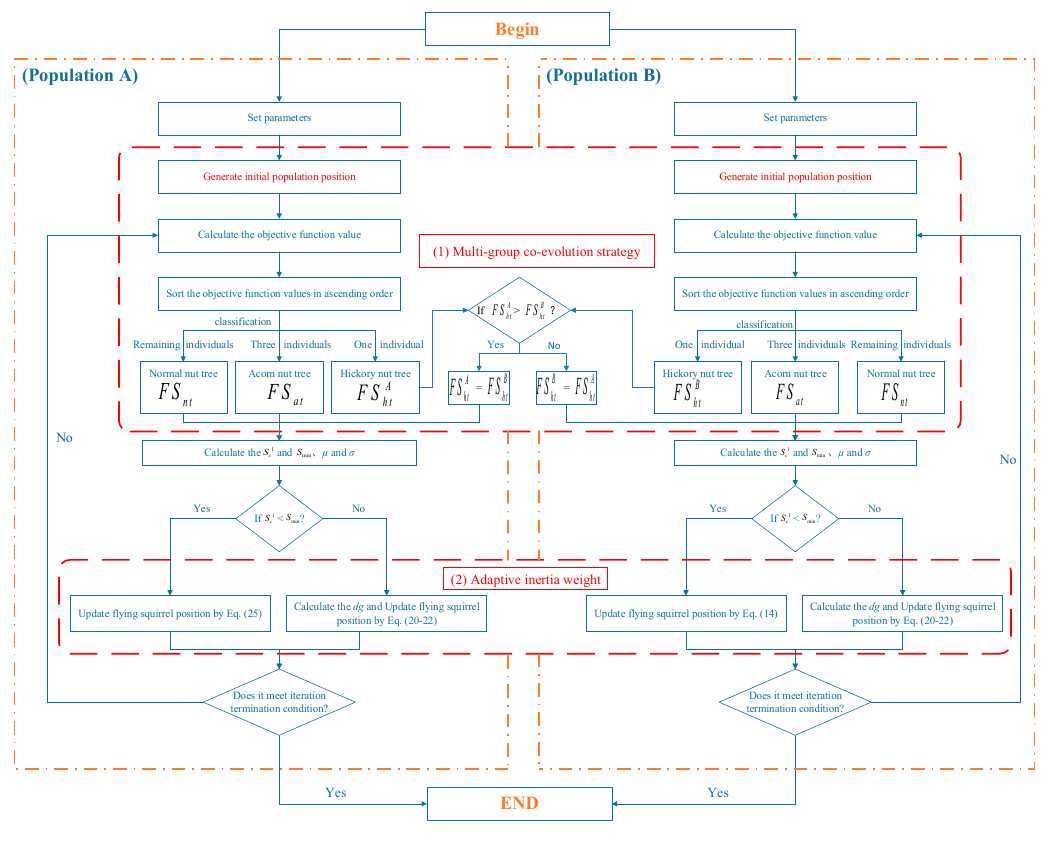
Figure 2. MASSA algorithm